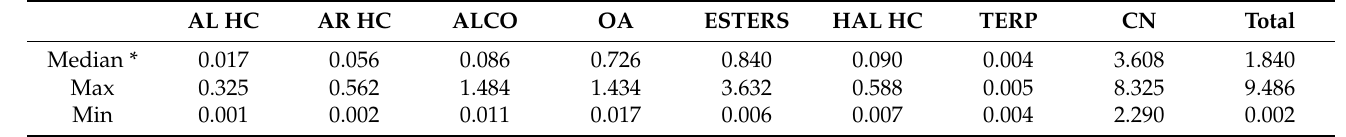
Table 8. Hazard Index of chemical substances sampled by volunteers in Seiffen, 2017–2018.